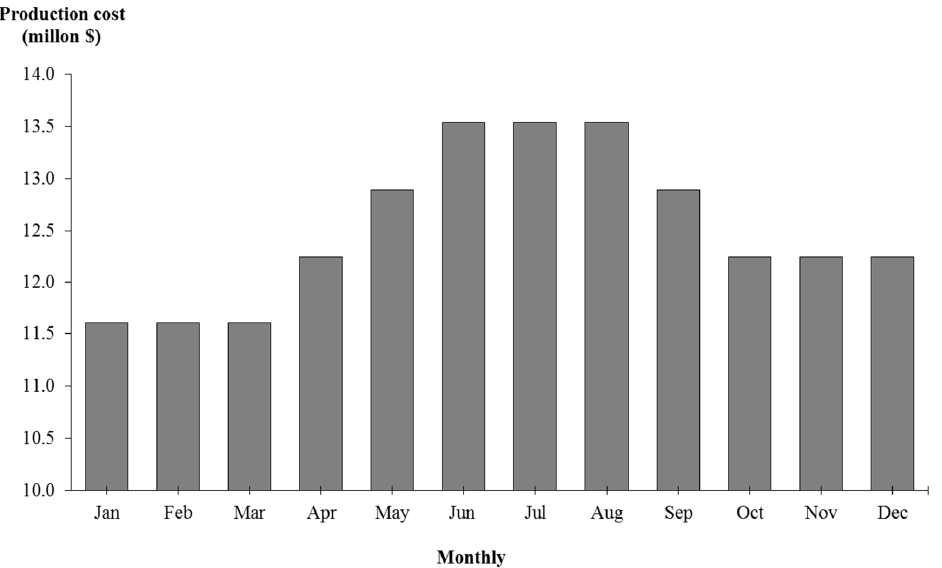
Figure 4. The monthly production cost of annual operation.